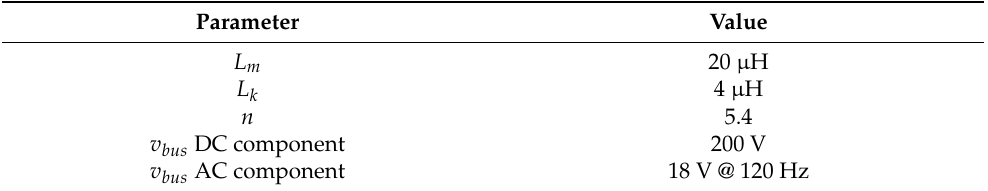
Table 2. Electrical parameters of the flyback